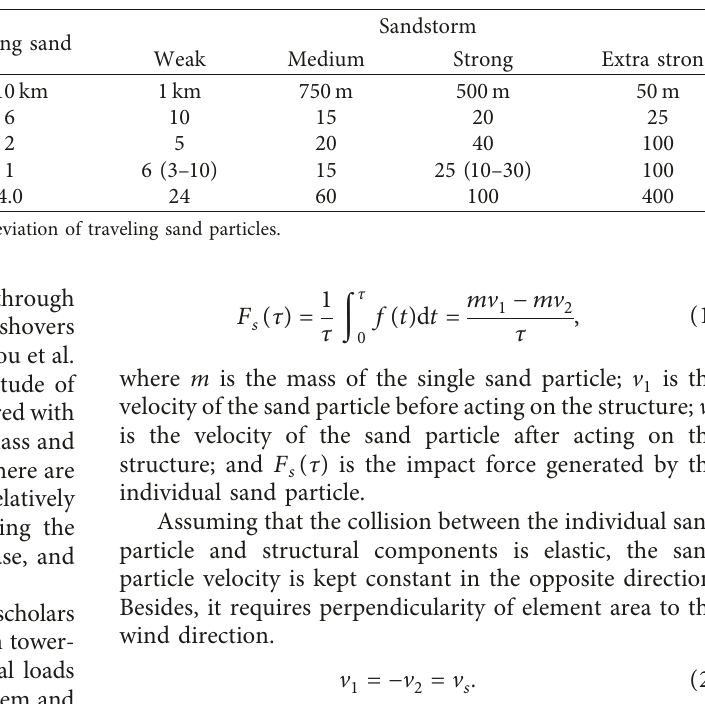
Table 1: Parameters of the typical intensity of